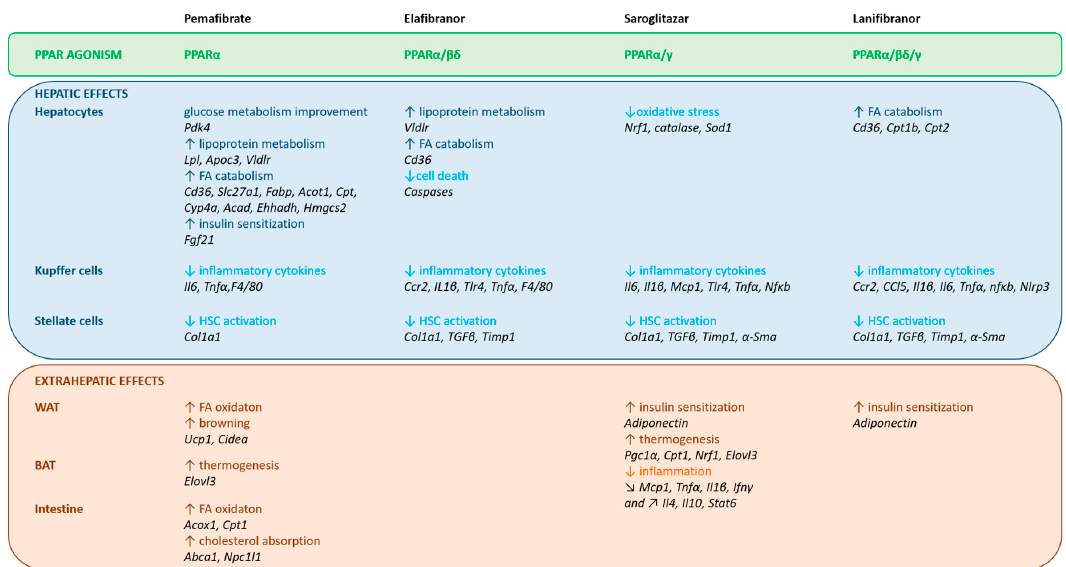
Figure 5. Novel PPAR agonists with potential for NAFLD treatment. The main genes regulated by the PPAR α agonist pemafibrate, the dual PPAR α and β / δ agonist elafibranor, the dual PPAR α and γ agonist saroglitazar, and the pan-PPAR agonist lanifibranor in preclinical models of NAFLD. Through the modulation of gene expression, these novel compounds regulate several hepatic and extrahepatic pathways, including lipid and glucose metabolism, inflammation, and hepatic stellate cell activation, which are all key processes involved in NAFLD. Abbreviations: BAT, brown adipose tissue; WAT, white adipose tissue; Pdk4, pyruvate dehydrogenase kinase 4; Lpl, lipoprotein lipase; ApoC3, apolipoprotein C3; Vldlr, very-low density lipoprotein receptor; Cpt, carnitine palmitoyltransferase; Slc27a1, solute carrier family 27 member 1; Fabp, fatty acid binding protein; Cyp4a, cytochrome P450 family 4 subfamily A; Ehhadh, enoyl-CoA hydratase and 3-hydroxyacyl CoA dehydrogenase; Acad, acyl-CoA dehydrogenase; Hmgcs2, 3-hydroxy-3-methylglutaryl-CoA synthase 2; Acot1, acyl-CoA thioesterase 1; Fgf21, fibroblast growth factor 21; Nrf1, nuclear respiratory factor 1; Sod1, superoxide dismutase 1; Il1 β , interleukin-1 beta; Il6, interleukin-6; Tnf α , tumor necrosis factor-alpha; Ccr2, C-C motif chemokine receptor 2; Tlr4, Toll-like receptor 4; Mcp1, monocyte chemoattractant protein 1; Ccl5, C-C motif chemokine ligand 5; Nlrp3, NLR family pyrin domain containing 3; Nf κ b, nuclear factor kappa B subunit 1; Tgf β , transforming growth factor beta; Col1a1, collagen type I alpha 1 chain; Timp1, metalloproteinase inhibitor 1; α -Sma, alpha-smooth muscle actin; Ucp1, uncoupling protein